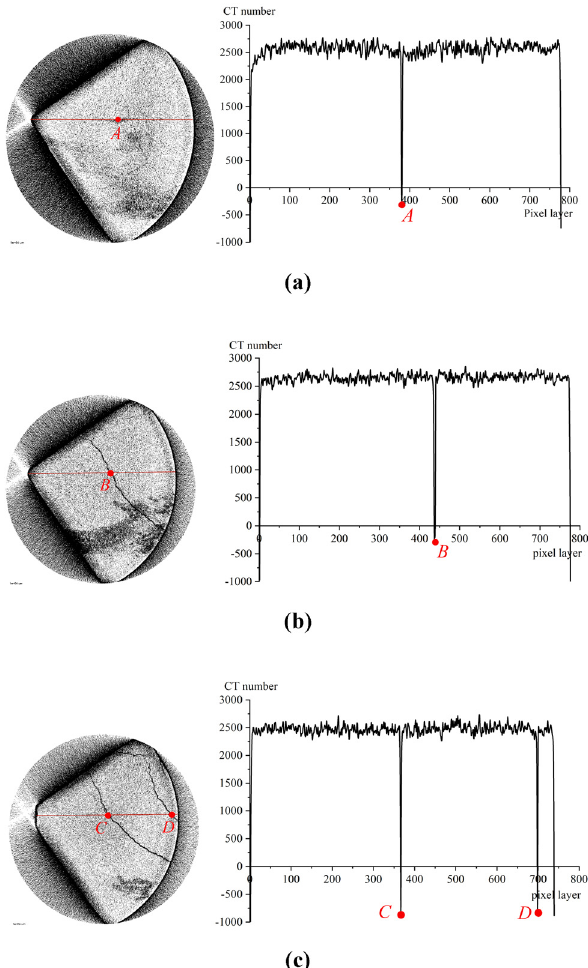
Figure 4: Distribution of the transverse CT number of the di ff erent layers of the test piece. ( a ) Layer 160th, ( b ) layer 450th, and ( c ) layer 730th.